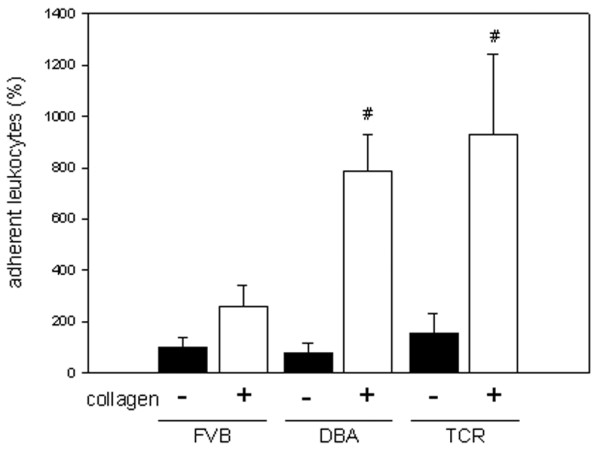
Leucocytes adherent to the endothelium of postcapillary synovial venules. Shown are the numbers of leucocytes adherent to the endothelium of postcapillary synovial venules (cells/mm2 endothelial surface) in complete Freund's adjuvant (CFA)/collagen II exposed FVB/NJ, DBA1/J and T-cell receptor (TCR) transgenic mice (collagen +) in comparison with CFA treated controls (collagen -). Intravital fluorescence microscopy of the knee joints was performed at 6 weeks after collagen exposure for induction of arthritis. Values are expressed as mean ± standard error (n = 5–10 animals/group); analysis of variance, unpaired post hoc comparison test: #P < 0.05 versus corresponding CFA-treated control animals (collagen -).